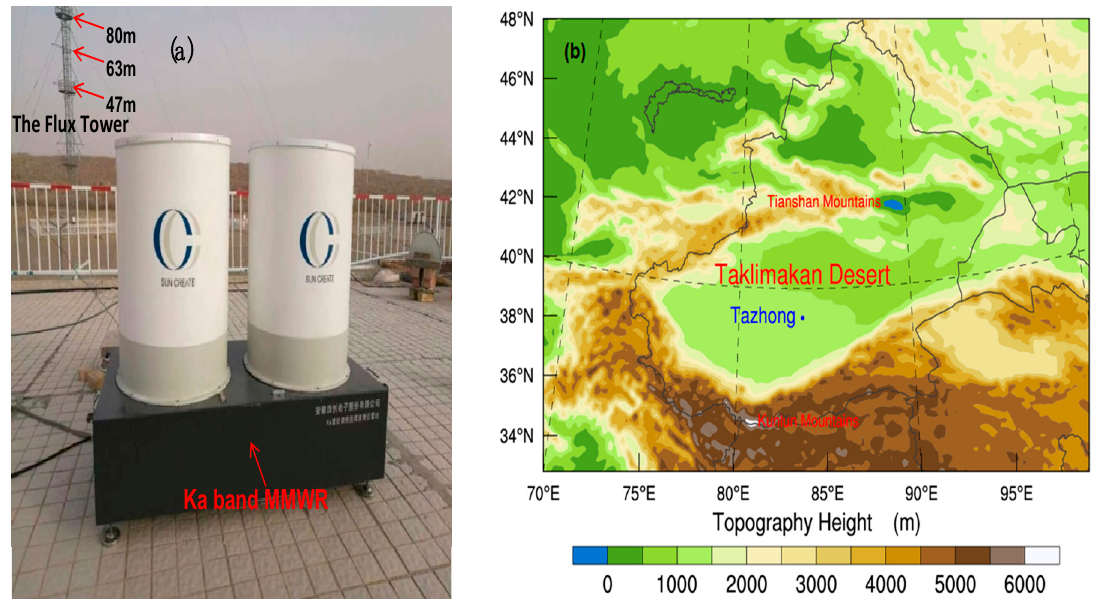
Figure 1. ( a ) Ka-band millimeter continuous wave radar; ( b ) the geographic position of Tazhong. Table 1. Parameters of Ka-band millimeter continuous wave radar.